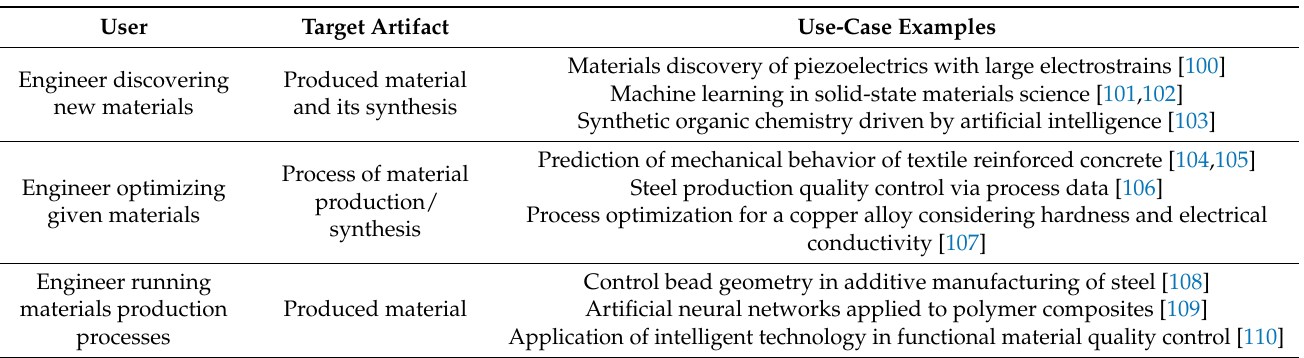
Table 7. Typical user roles in the material design